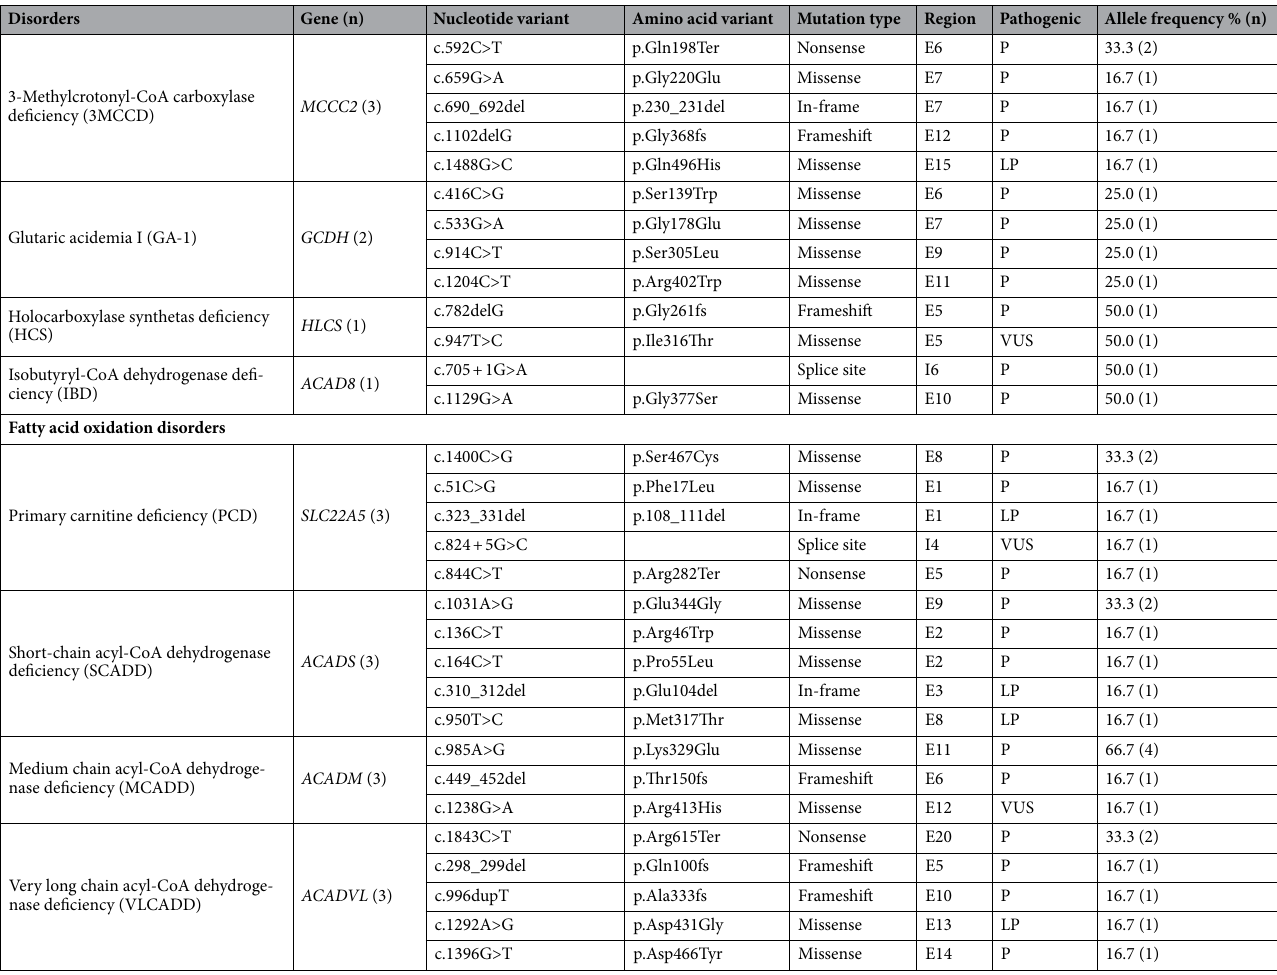
Table 4. Gene mutation spectrum of 61 infants with